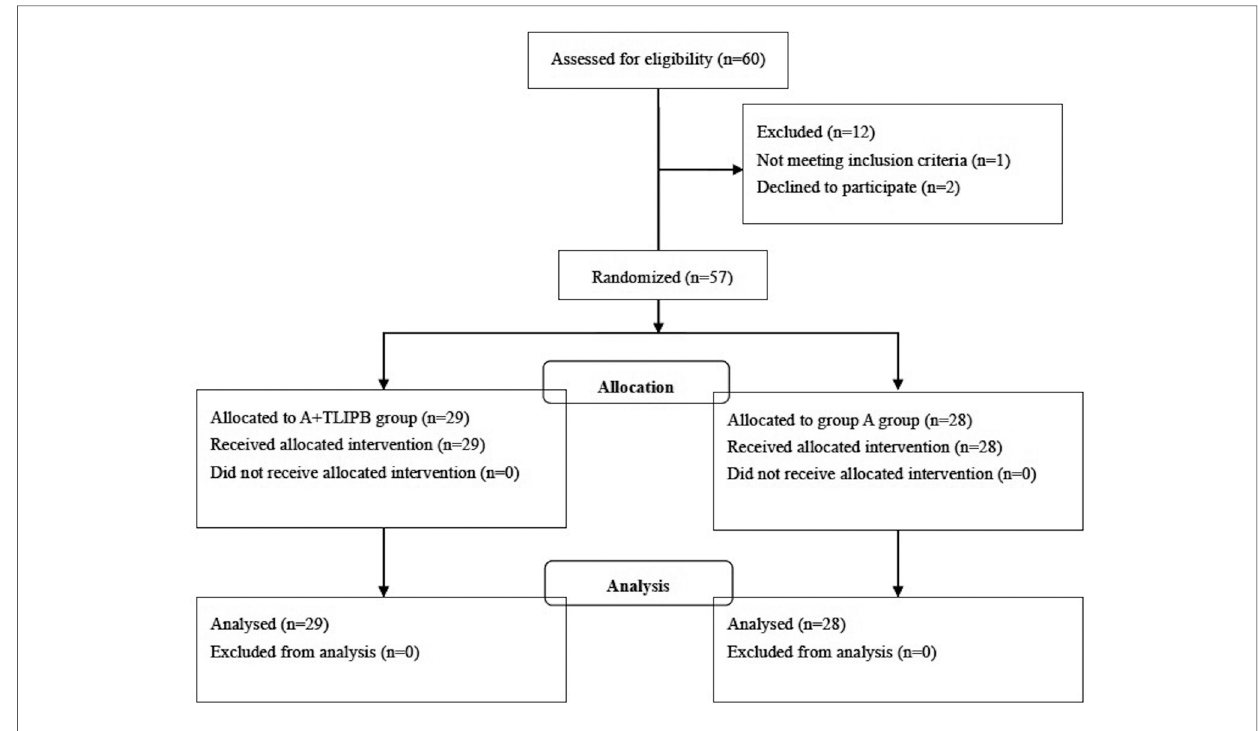
FIGURE 1 Flow diagram of patients and the study